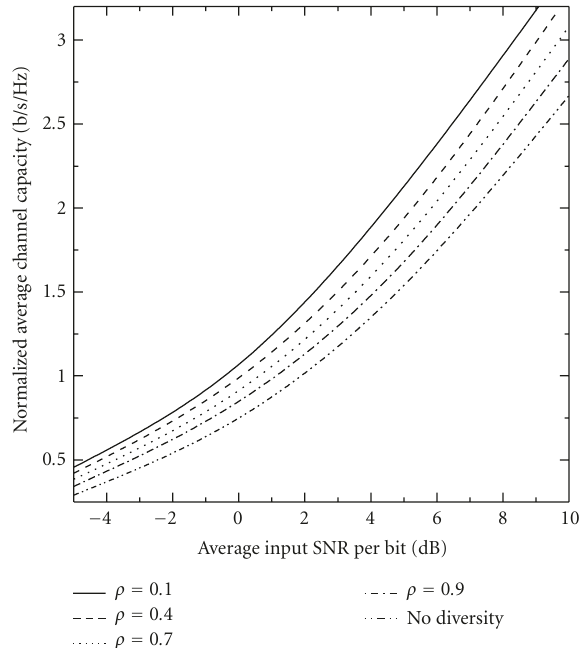
Figure 6: Normalized average channel capacity ( C/BW ) versus the average input SNR per bit for several values of the correlation coef- ficient ρ